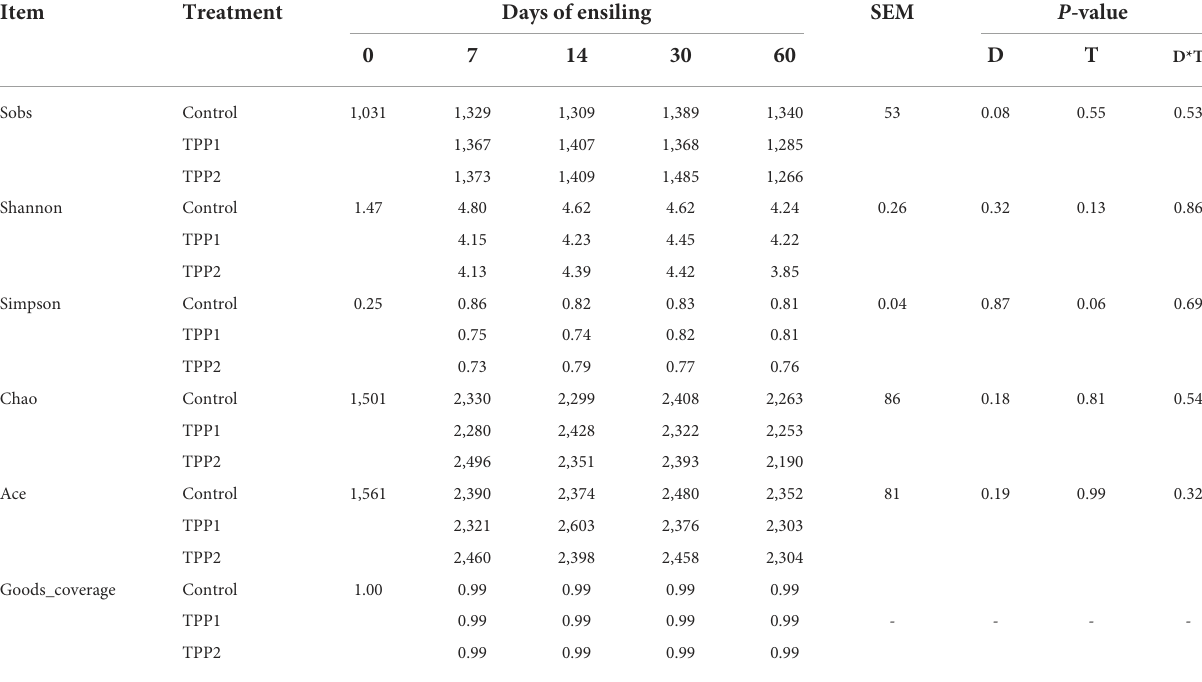
TABLE 5 Alpha diversity of bacterial community of stylo silage ensiled with addition of tea polyphenols.